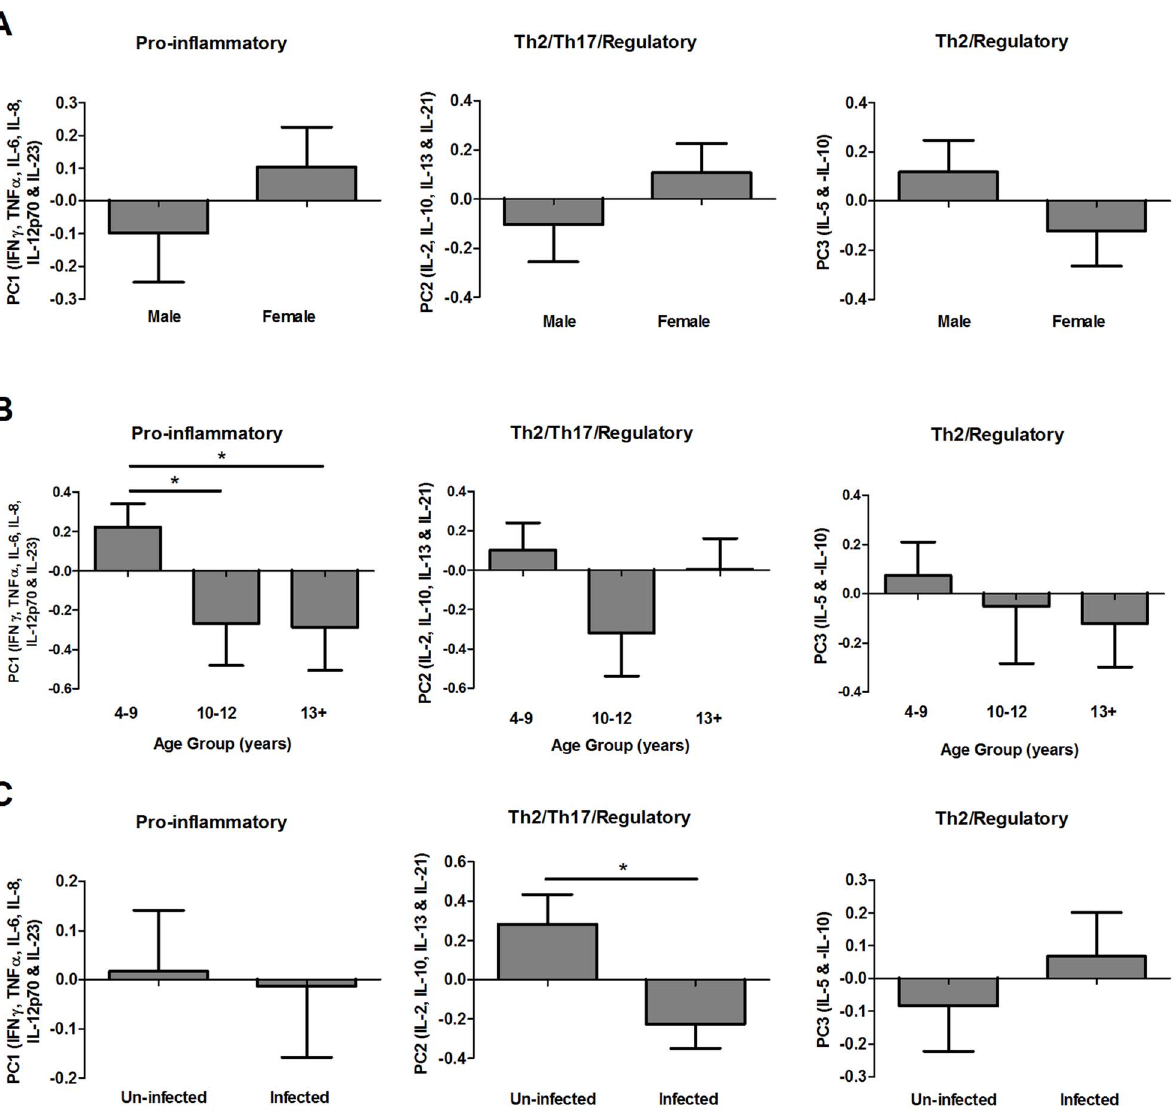
Figure 4. Distribution of post-treatment GST-specific cytokine profiles by gender, age group and S.haematobium infection status. Mean post-treatment principal component regression factor scores for cytokine profiles associated with pro-inflammatory (post-treatment PC1), Th2/ Th17/regulatory (post-treatment PC2) and Th2/regulatory (post-treatment PC3) responses sub-divided by gender ( A ), age group ( B ) and schistosome infection status at baseline ( C ; un-infected=egg negative in all urine samples, infected=egg positive in one or more urine samples). Error bars: standard error of the mean. Where ANOVA (sequential sums of squares accounting for variation in gender and age group before infection status) analysis indicated that age group contributed to variation in cytokine profiles, pair-wise comparisons of PC scores were conducted via post-hoc Fisher’s least significant difference tests between the 3 age groups (n=107);*p , 0.05.